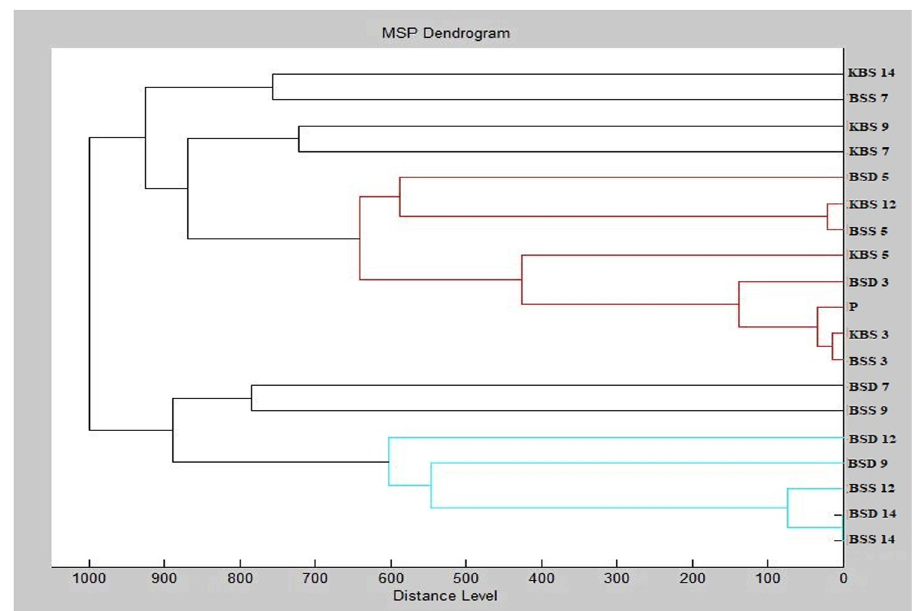
Figure 5: Dendrogram of B. subtilis generated using the MSP for the planktonic cells and all experimental groups. Sample name abbre - viations: K, control; BS, Bacillus subtilis ; S, glass; D, wood; P, planktonic